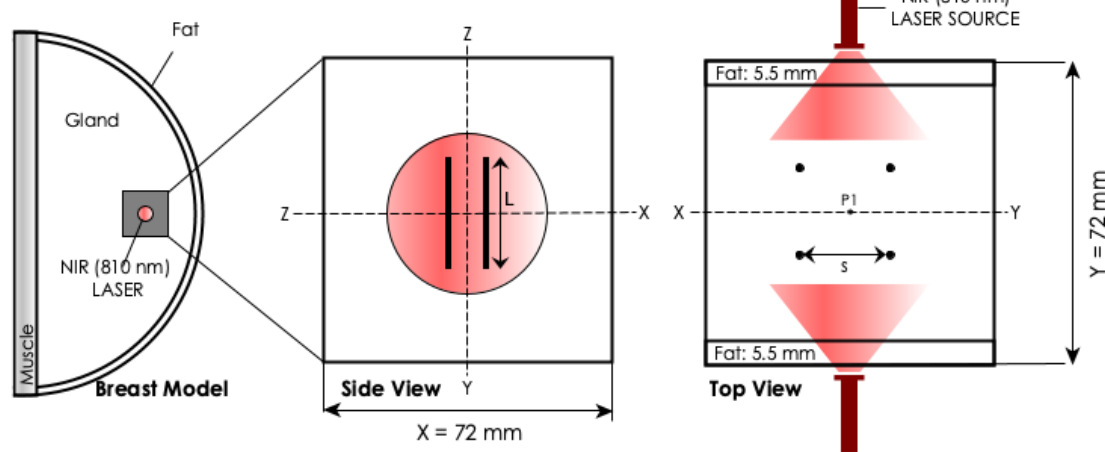
Figure 2. FEM geometry. Schematic of the model used to predict the in-vivo photothermal heating. d is the distance between adjacent photoseeds and L is the length of the